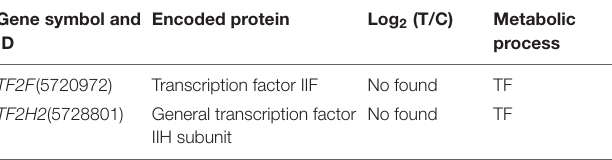
TABLE 3 | Genes regulated by DpWRI1-like in D. parva